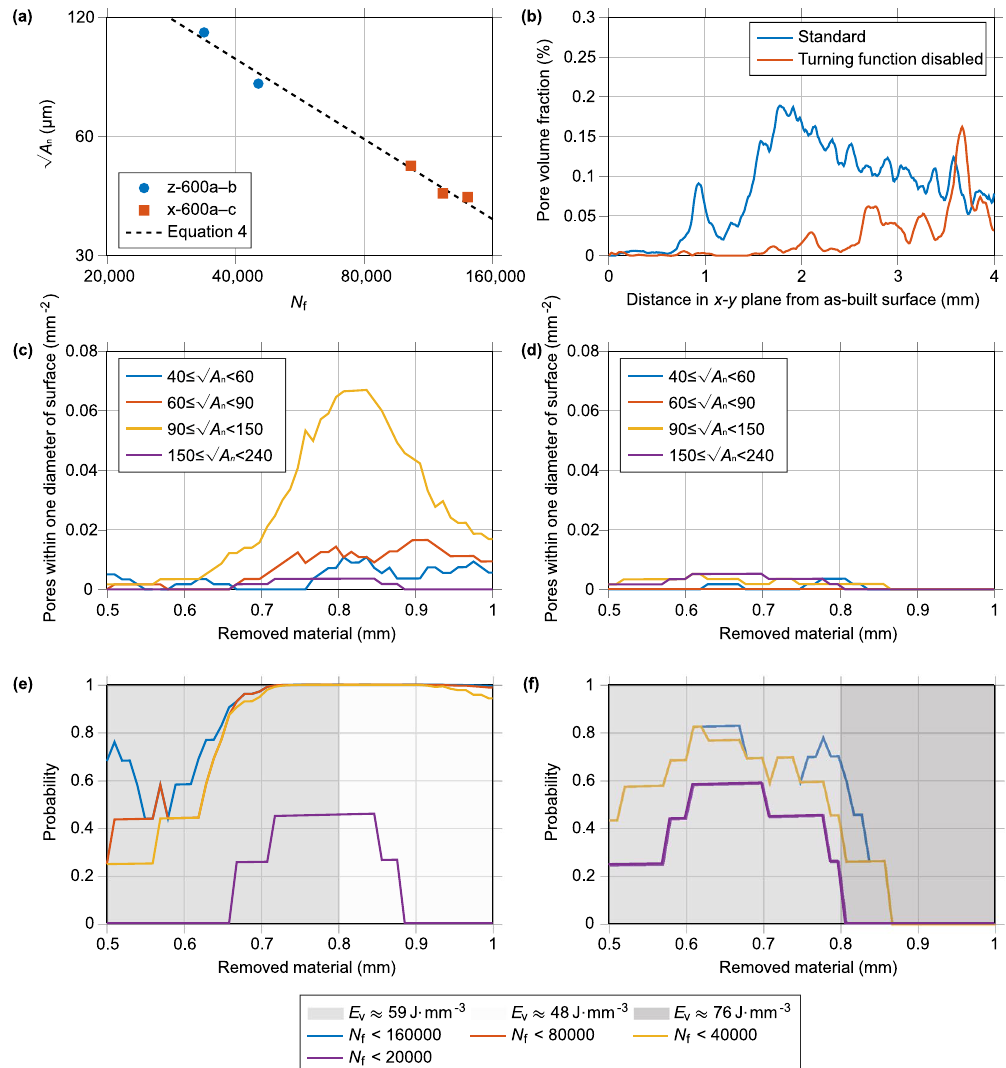
Figure 10. Distribution of porosity near the as-built surface of EBM components and its possible effect on fatigue life – ( a ) the size of pores identified on the fracture surface by SEM for samples against cycle to failure for samples tested at 600 MPa and failing from surface pores. (The standard deviation in measured pore size is contained within the marker size). ( b ) The total volume fraction of porosity with distance from the surface for standard and modified melt strategies (adapted from ref. 3). The number density of pores within one diameter of the surface when machining to different depths for a sample melted with ( c ) standard, and ( d ) slightly modified melt strategies. The probability of at least one pore with a size large enough to cause failure within a given number of cycles appearing near the machined surface for a ( e ) standard sample and ( f ) modified sample. In ( e ) and ( f ) the energy density ( E v ) used to melt each area is given by the background